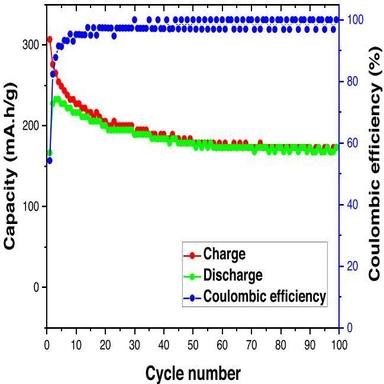
Charge-discharge cycling performances for the Fe-BDC at 30 mA/g.